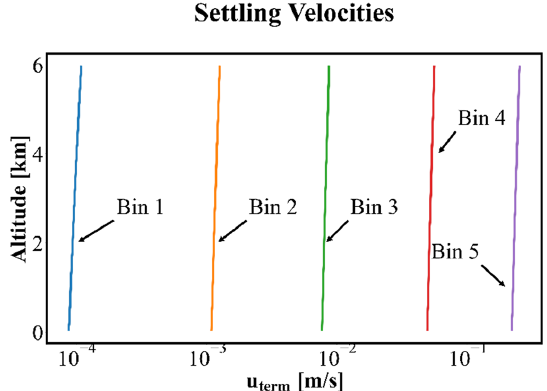
Figure 4. Terminal velocities of the CONTROL experiment, av- eraged for the simulation time and the domain. Each colored line corresponds to one of the new model size bins, with blue: bin 1, orange: bin 2, green: bin 3, red: bin 4, and purple: bin